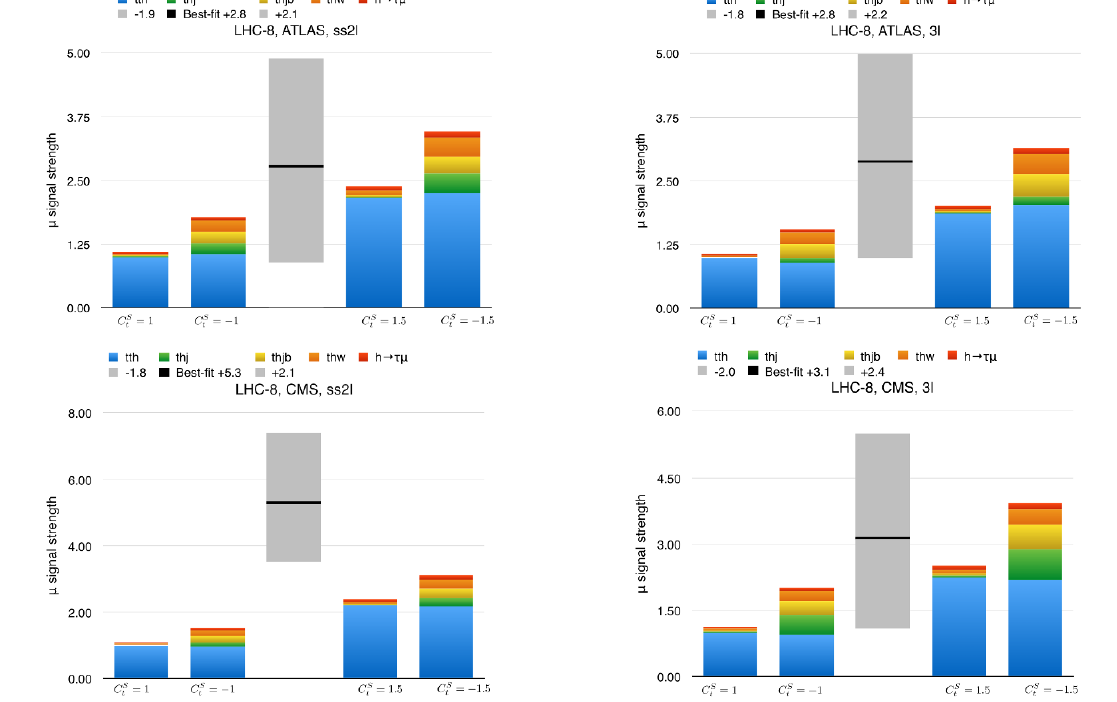
Figure 5 . Category Leptons: accumulated signal strengths (cid:22) ATLAS (upper left), (cid:22) ATLAS (upper tth;ss 2 ‘ tth; 3 ‘ right), (cid:22) CMS (lower left), and (cid:22) CMS (lower right) at LHC-8 obtained by stacking the various tth;ss 2 ‘ tth; 3 ‘ thX contributions on the t (cid:22) th one for C S = +1 ; (cid:0) 1 ; +1 : 5 ; (cid:0) 1 : 5 from left to right. The grey columns t in the center represent the current 8 TeV LHC data from table